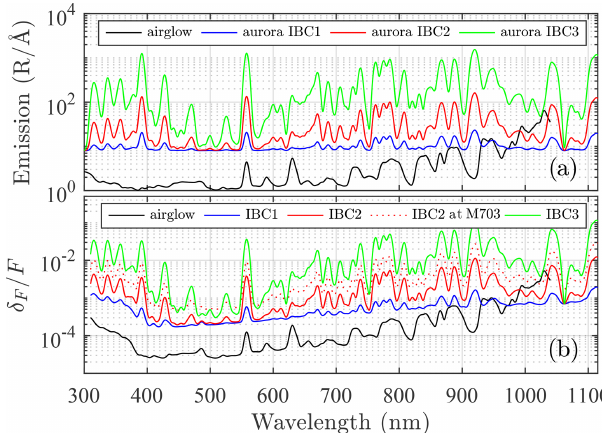
Figure 15. (a) Typical emission density spectrum for airglow and aurora. (b) Corresponding optical depth error in the presence of un- corrected emission contributions: δ τ = δ F /F (from Eq. 32 for m = 1), representing the ratio of emission to a Vega spectrum dimmed to V = 3 and attenuated in a Rayleigh atmosphere. When observing a V = 0 . 5 star, the corresponding aurora IBC types can be one class brighter to achieve the same optical depth errors. The red dots show comparative V = 3 results for the (larger FOV) M703 instrument (see text for